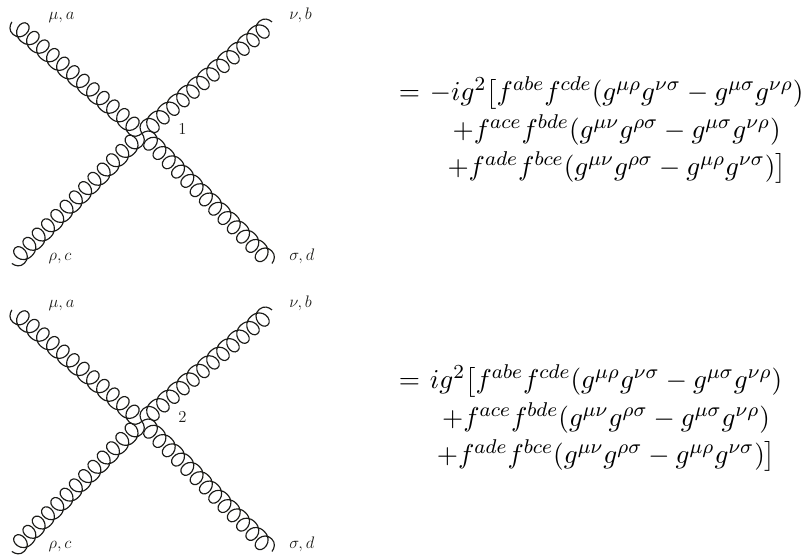
Figure 11. Feynman rules associated to the 4-gauge boson vertex, given here for the time-ordered and anti-time ordered branches of the Schwinger-Keldysh contour. The anti-time ordered branch multiplies the vertex factors by ( − 1) , which is naturally included in the notation we adopt in the main